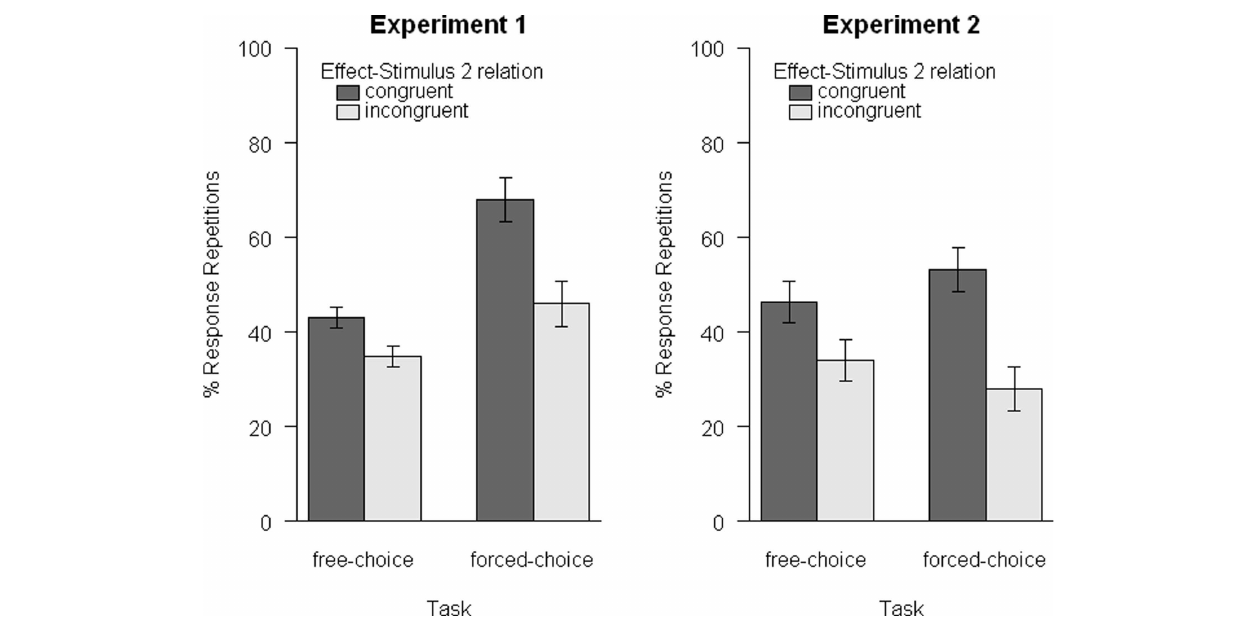
consistently for both tasks in both experiments. Error bars are within-subjects standard errors, calculated separately for each comparison of congruent and incongruent trials (Loftus and Masson,